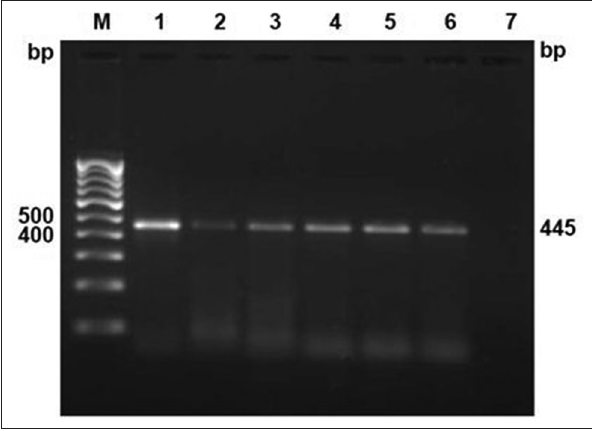
Figure-2: Culture isolates confirmation by polymerase chain reaction targeting IS 6110 sequence. Lane M: 100 bp DNA ladder; positive control (Lane 1: Mycobacterium tuberculosis H37Rv; Lane 2: Mycobacterium bovis BCG); Lane 3-6: Culture isolates